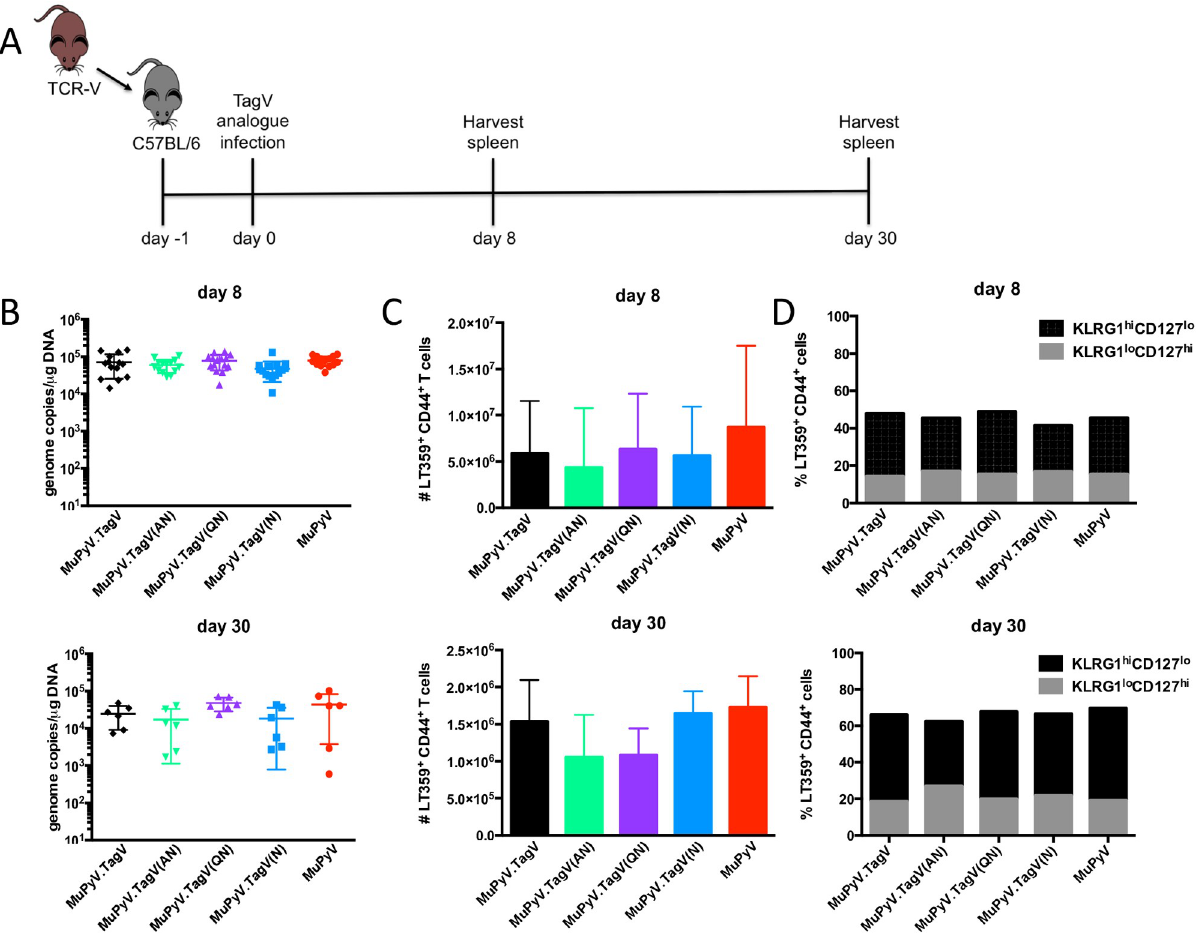
Fig 2. Infection by analogues of the subdominant TagV epitope does not affect the endogenous anti-MuPyV response. (A) 1 x 10 3 TCR-V CD8 T cells were adoptively transferred i.v. into B6 mice. Mice were infected with 2 x 10 6 PFU of MuPyV via hind footpads the followingday and sacrificedat day 8 or day 30 p.i. (B) Viral load in the spleenat day 8 (top panel)or day 30 (bottom panel)p.i. (C) Number of LT359-specific CD8 T cells in the spleenat day 8 p.i. (top panel) or day 30 p.i. (bottom panel). (D) Percent of LT359-specific CD8 T cells that are KLRG1 hi CD127 lo (black) and KLRG1 lo CD127 hi (gray) at day 8 (top panel)or day 30 (bottom panel)p.i. Mean ± SD plotted: no significant differences. N = 12–18 mice from 4–6 independent experiments.